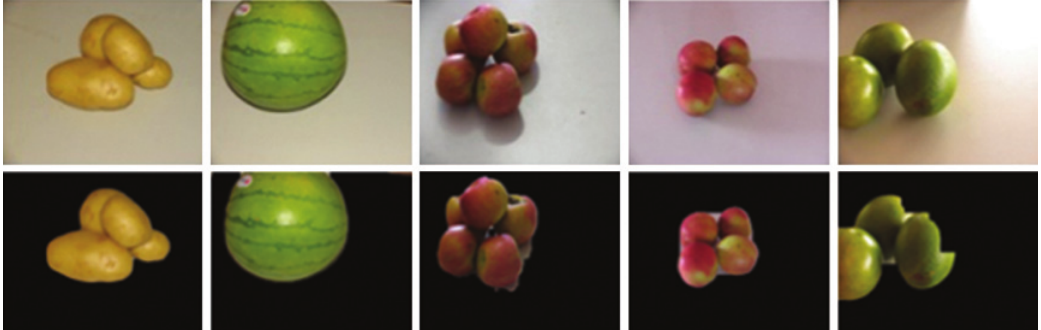
Figure 2. Some Image Segmentation Result on the Fruit and Vegetable Images